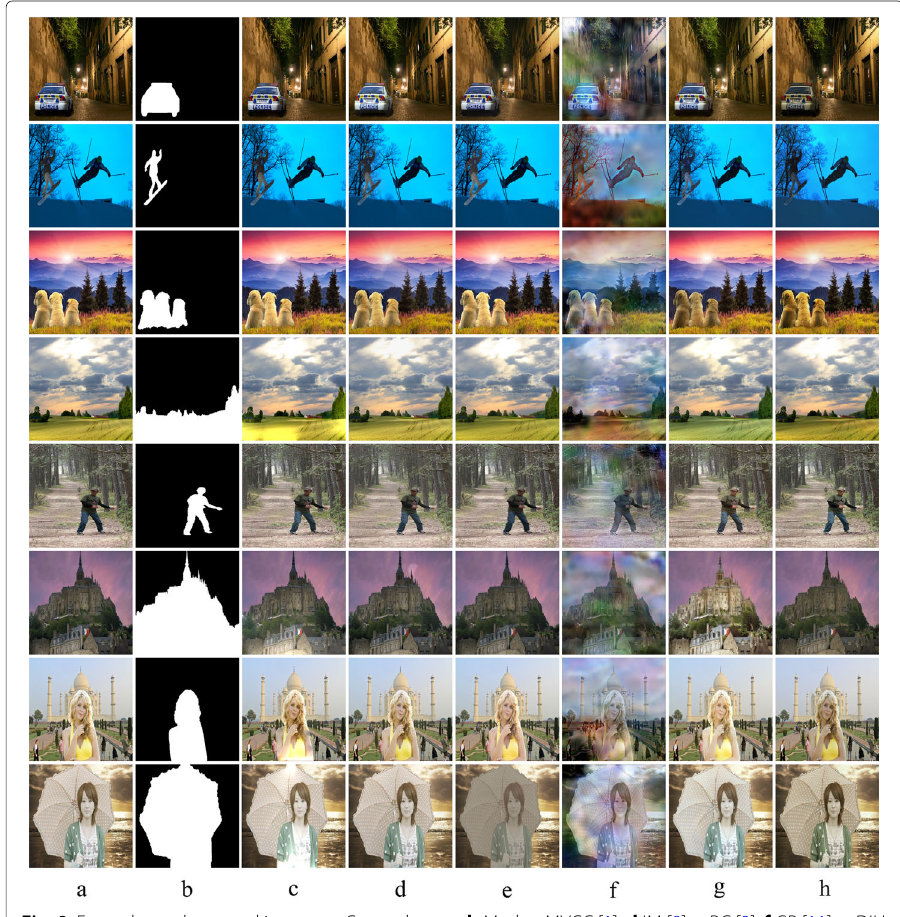
Fig. 8 Example results on real images. a Cut-and-paste. b Mask. c MVCC [1]. d IM [8]. e RC [2]. f GP [11]. g DIH [3]. h Our proposed network